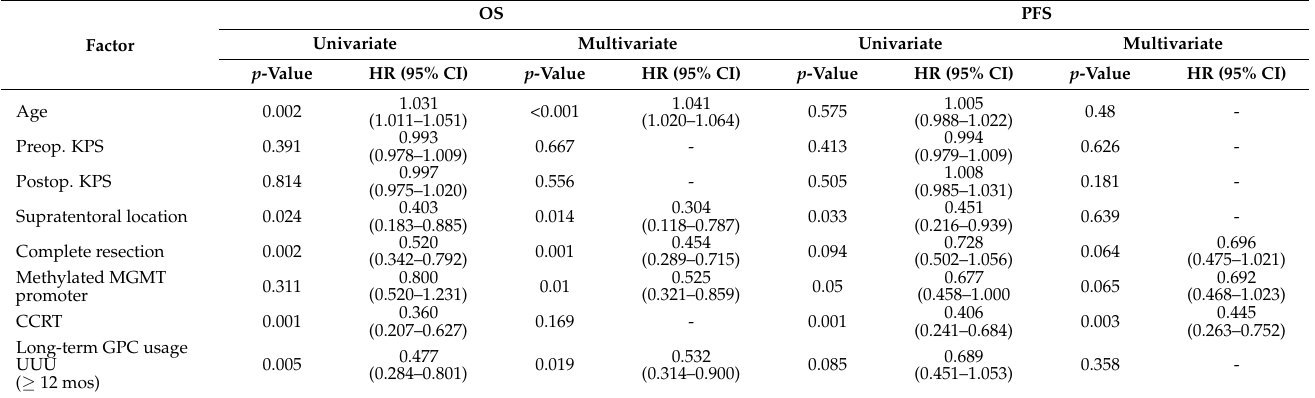
Table 4. Prognostic factors for OS and PFS in patients followed for more than 12 months ( n =